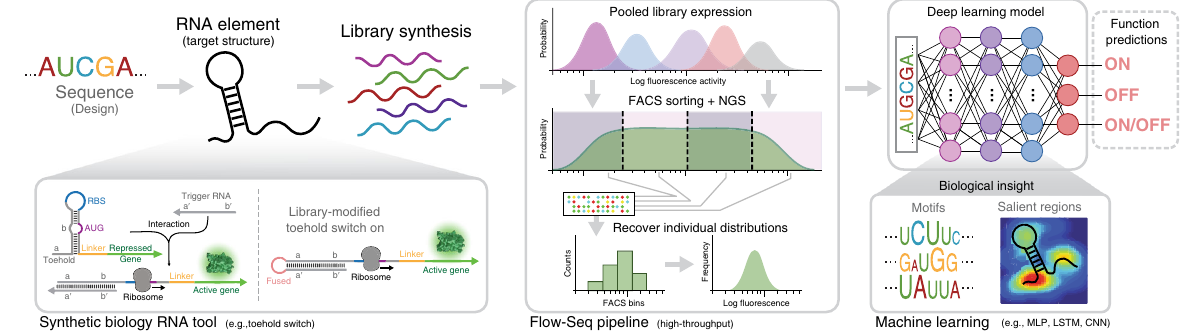
Fig. 1 Deep learning for ribonucleic acid (RNA) synthetic biology pipeline. RNA tool selection is followed by library synthesis and characterization with analysis using deep neural networks (DNN) to provide functionality predictions and biological insights. We used a high-throughput toehold-switch library as a canonical model for the general investigation of RNA synthetic biology tools. The original toehold-switch architecture from Green et al. 2 was used, containing a 12-nucleotide toehold (a/a ′ ) and an 18-nucleotide stem (b/b ′ ) fully unwound by the trigger (left-bottom). We selected to fuse the RNA trigger to the 5 ′ end of the switch by an unstructured linker to facilitate library synthesis. A fl ow-sequence (seq) pipeline was used to characterize the fl uorescence signal of individual toehold switches in a pooled sequential assay, including pooled induction, fl uorescence-activated cell sorter (FACS) sorting, next-generation sequencing (NGS), and count frequency analysis. Finally, various DNN architectures were used to predict data outputs, while features contributing to DNN predictions were intuitively visualized to elucidate biological insights. Center panel adapted from Peterman et al. 24